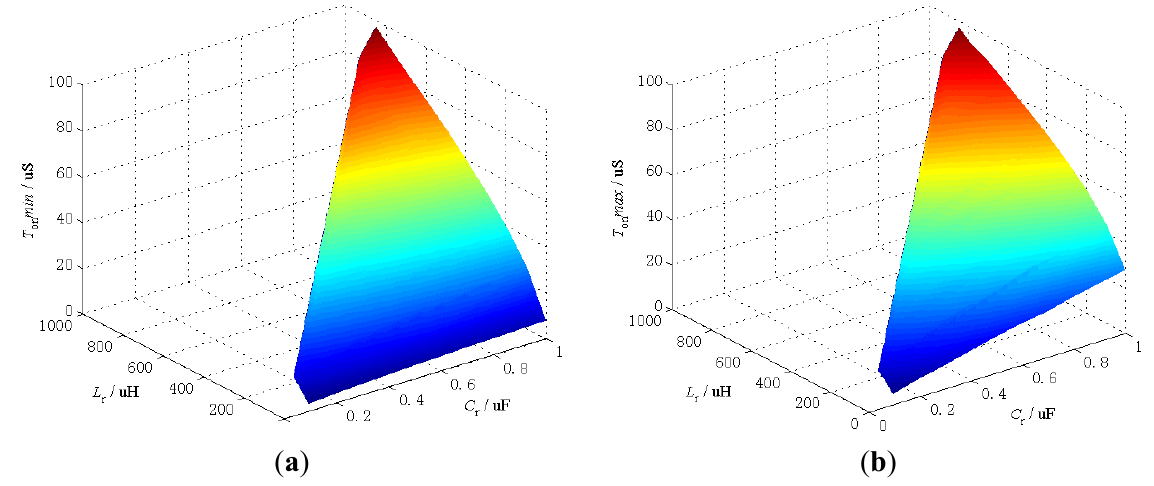
Figure 10. Minimum and maximum T on value to realize zero-current-switching (ZCS).